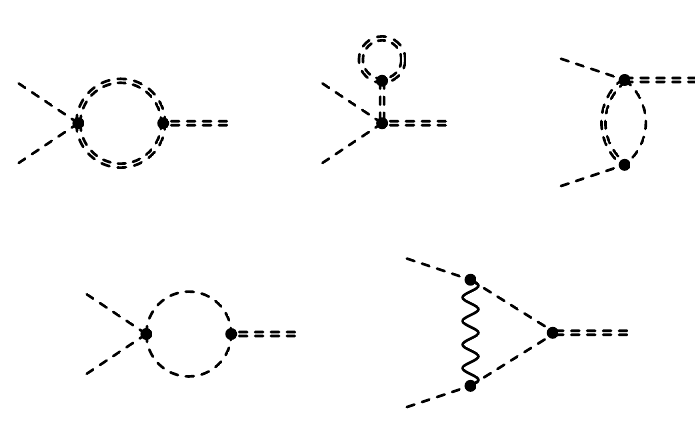
Figure 7 . Examples of one-loop contributions to the renormalisation of the coupling A . The UV poles of the (cid:12)rst and second graph cancel against each other in the MS scheme. The line styles and their meanings are analogue to those of (cid:12)gure 5.